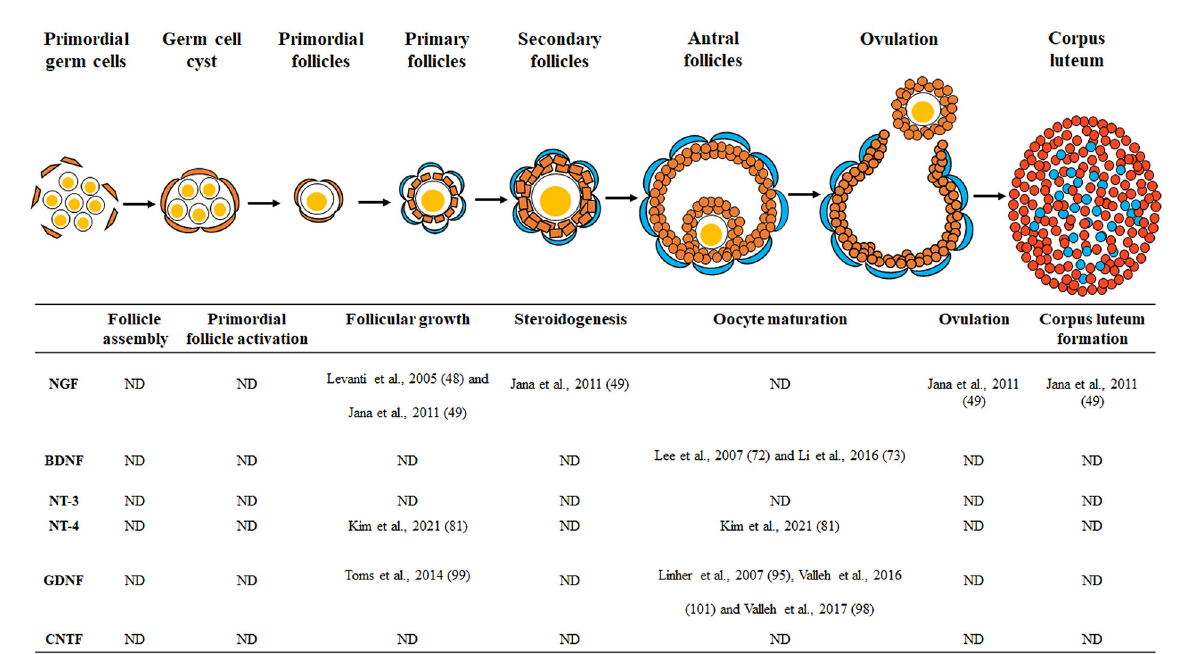
FIGURE1 Schematic drawing of the neurotrophic factors involved in porcine ovarian and follicular development. Neurotrophic factors regulate porcine ovarian folliculogenesis, which involves follicle assembly, primordial follicle activation, follicular growth, steroidogenesis, oocyte maturation, ovulation, and corpus luteum formation. ND, no